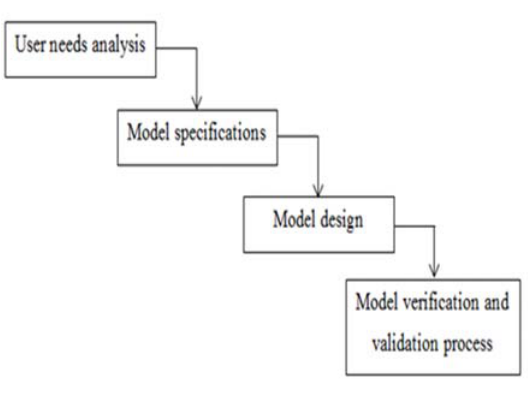
Fig. 2. Optical quantum channel simulator software.